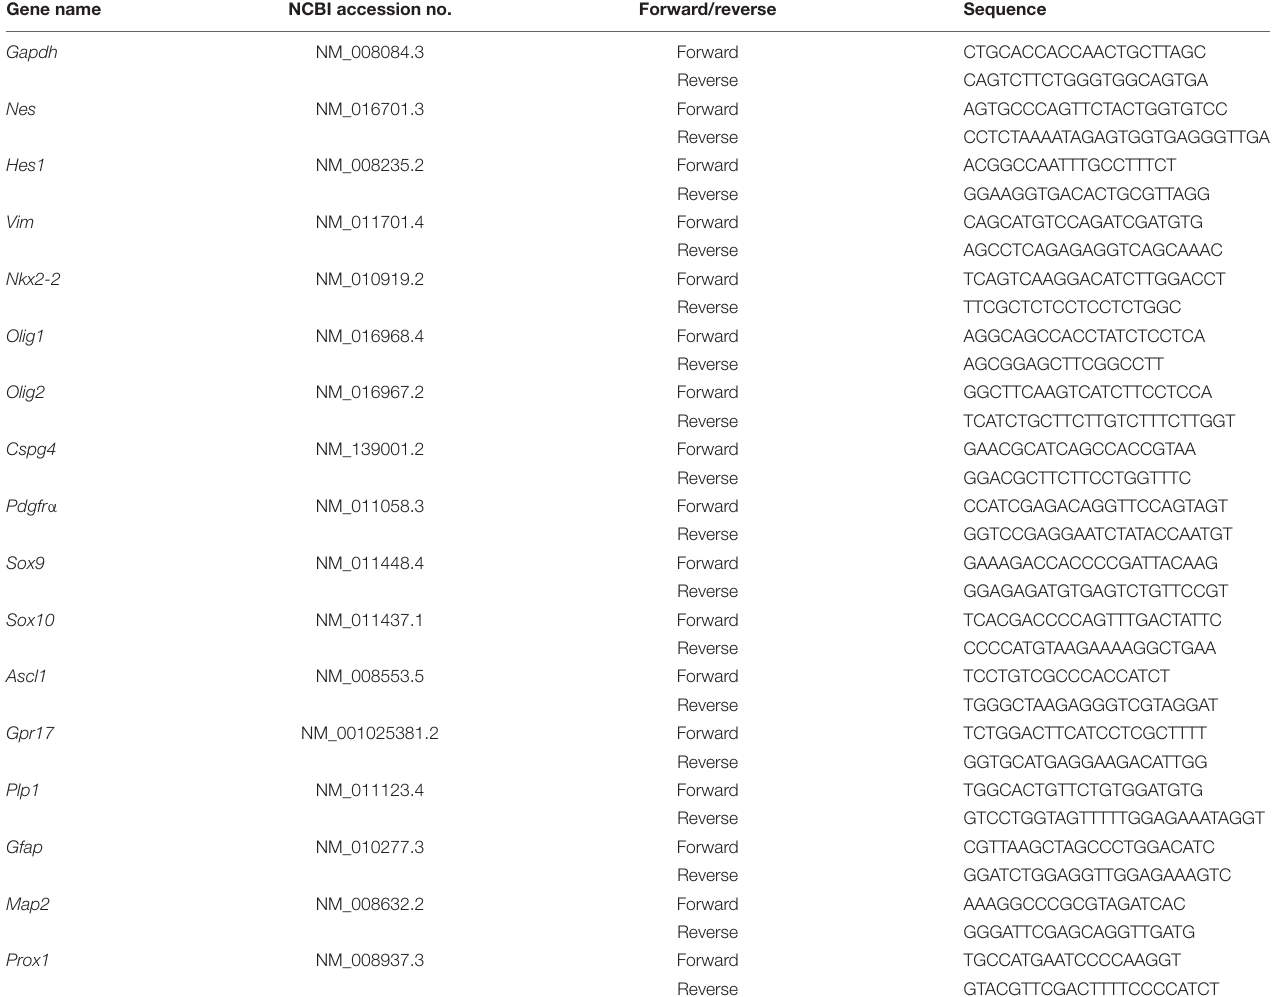
TABLE 1 | List of primers for